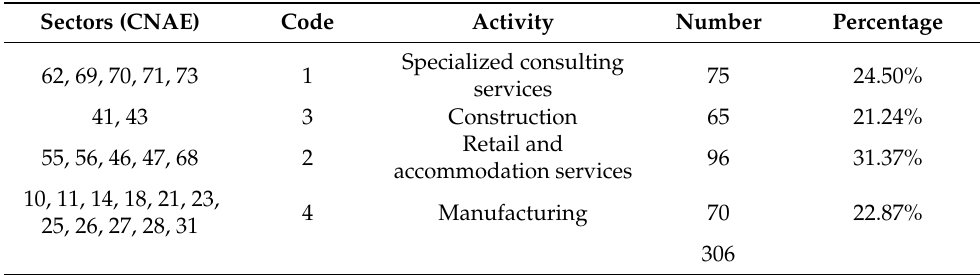
Table 2. Sector and activity of the analyzed